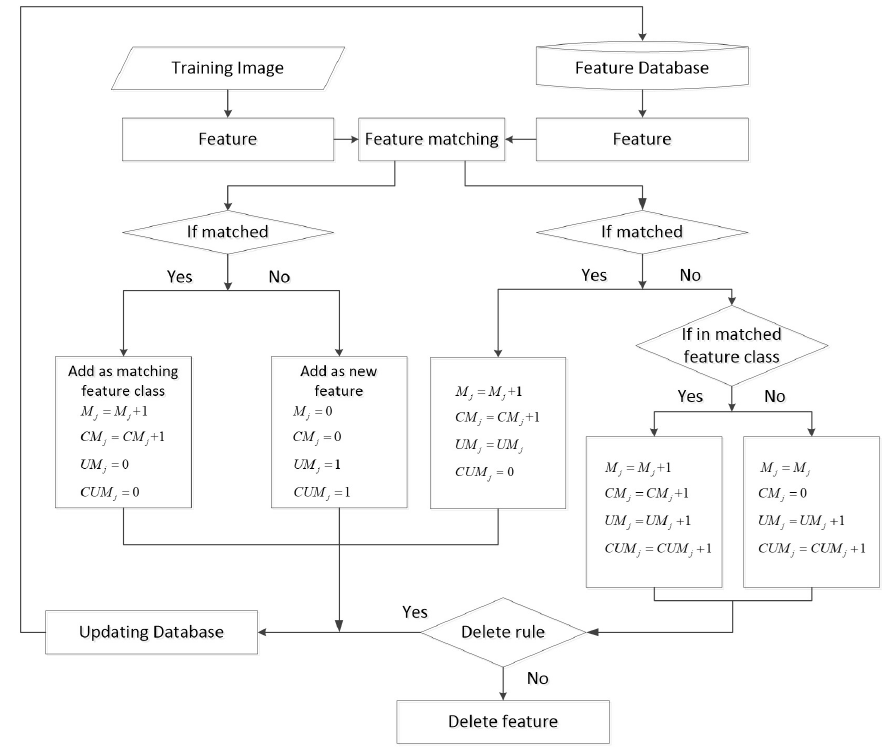
Figure 2. Flow chart of feature database